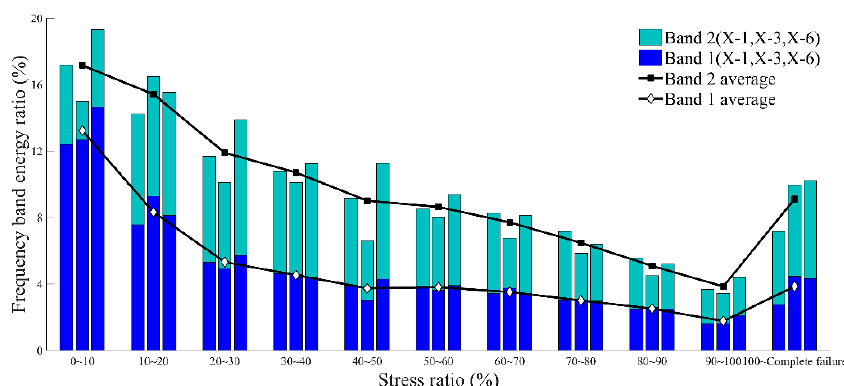
Figure 10. The relationship between the stress ratio and the average energy ratio in the low-frequency band (bands 1 and 2).